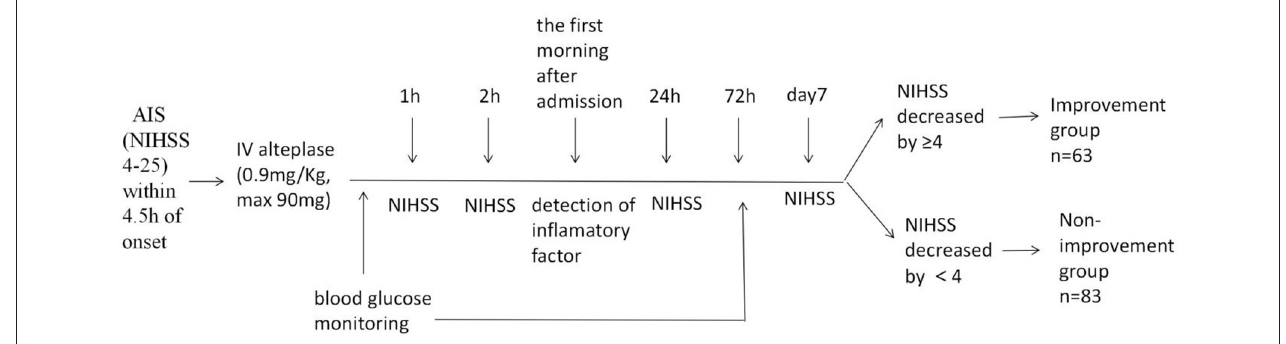
FIGURE 1 | Study schema. AIS, acute ischemic stroke; NIHSS, National Institutes of Health Stroke Scale; IV, intravenous.